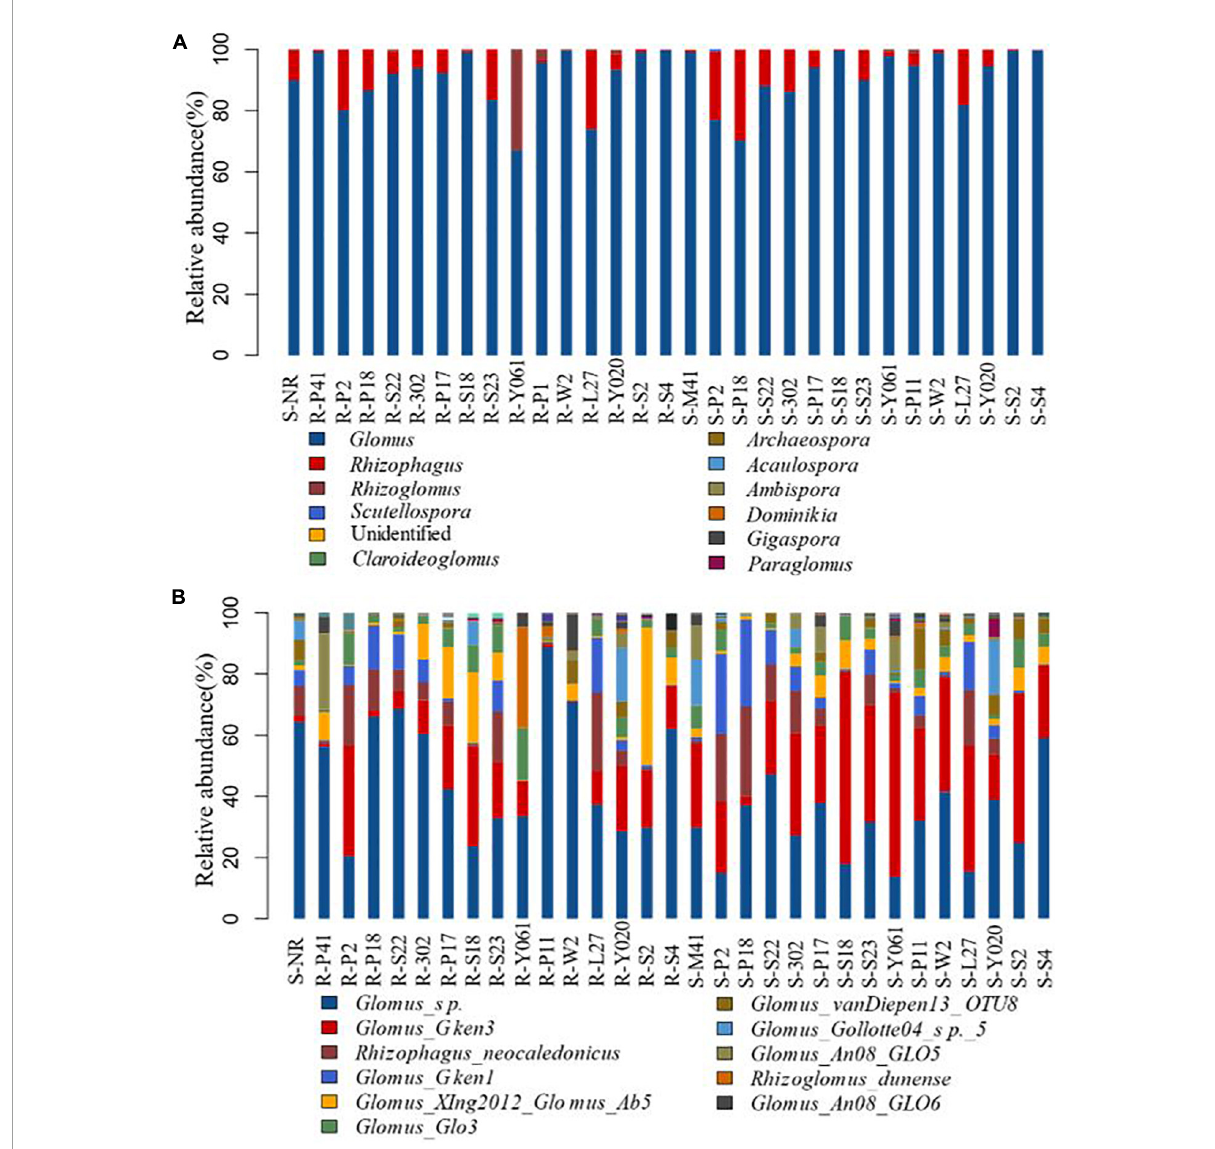
FIGURE6 The relative abundance at AMF genus level (A) and species level (B) in different clones of Chinese fir plantations. On the horizontal axis, S-NR represents bulk soil, R-represents root system, S-represents rhizosphere soil, and the subsequent number indicates clones.